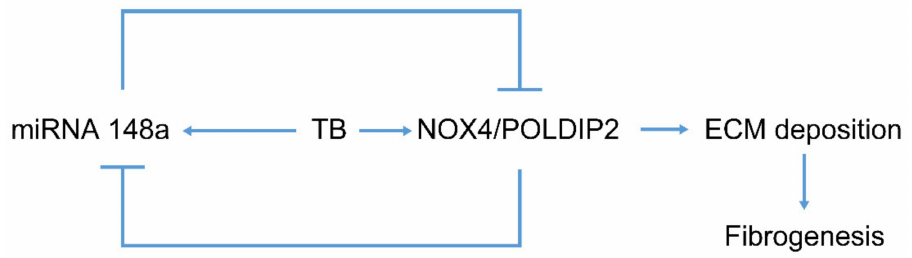
Figure 7. Regulation of tuberculous fibrosis by miR-148a. Chronic HKMT exposure induces miR-148a expression. Initially, TB downregulates miRNA 148a, but finally upregulates miR-148a. Overexpres- sion of miR-148a in mesothelial cells blocked NOX4 and POLDIP2 expression, thus preventing ECM deposition and lung fibrogenesis. NOX4 may also inhibit the expression of miR-148a, providing a negative feedback